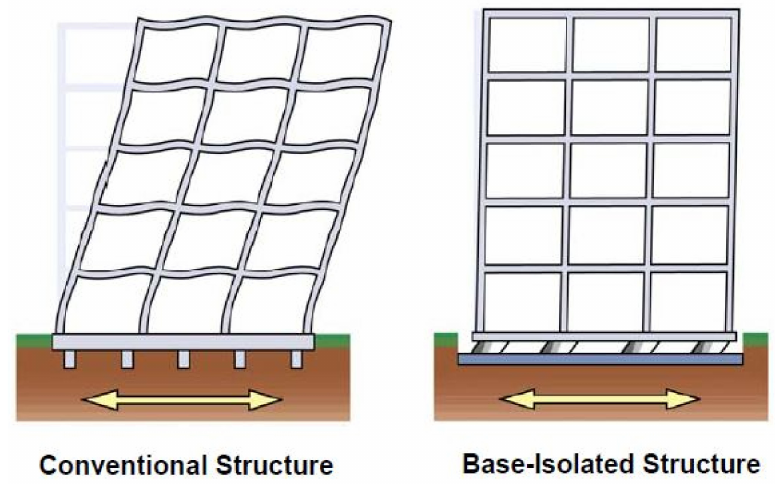
Figure 1. Schematic representation of deformations of conventional non-isolated and base-isolated structures [5].